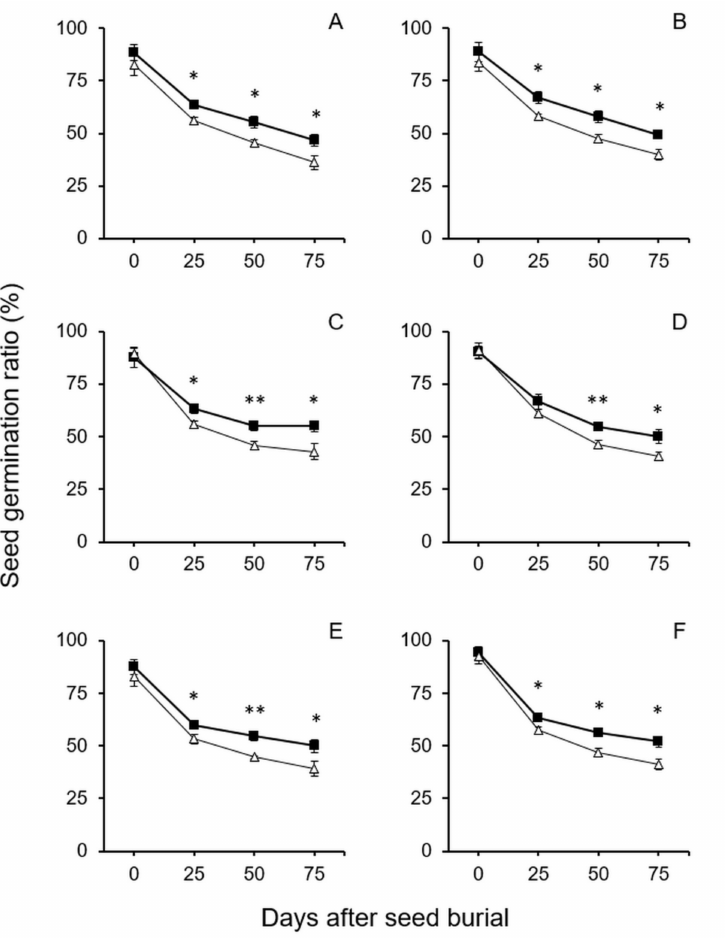
Figure 4. Average germination ratios of GE and non-GE seeds (F 4 –F 6 ) from the transgenic crop (EP3)–wild rice (w1 or w2) hybrid lineages after soil burial treatments at 0, 25, 50, and 75 days. The dormancy-breaking treatment was conducted before seed burial. ( A , B ) F 4 of EP3–w1 and EP3–w2; ( C , D ) F 5 of EP3–w1 and EP3–w2; ( E , F ) F 6 of EP3–w1 and EP3–w2. Comparisons were made between GE (solid squares) and non-GE (empty triangles) seed germination based on the independent-sample Student’s t -test. Bars represent standard error ( n = 6 replicates). * p < 0.05, ** p <